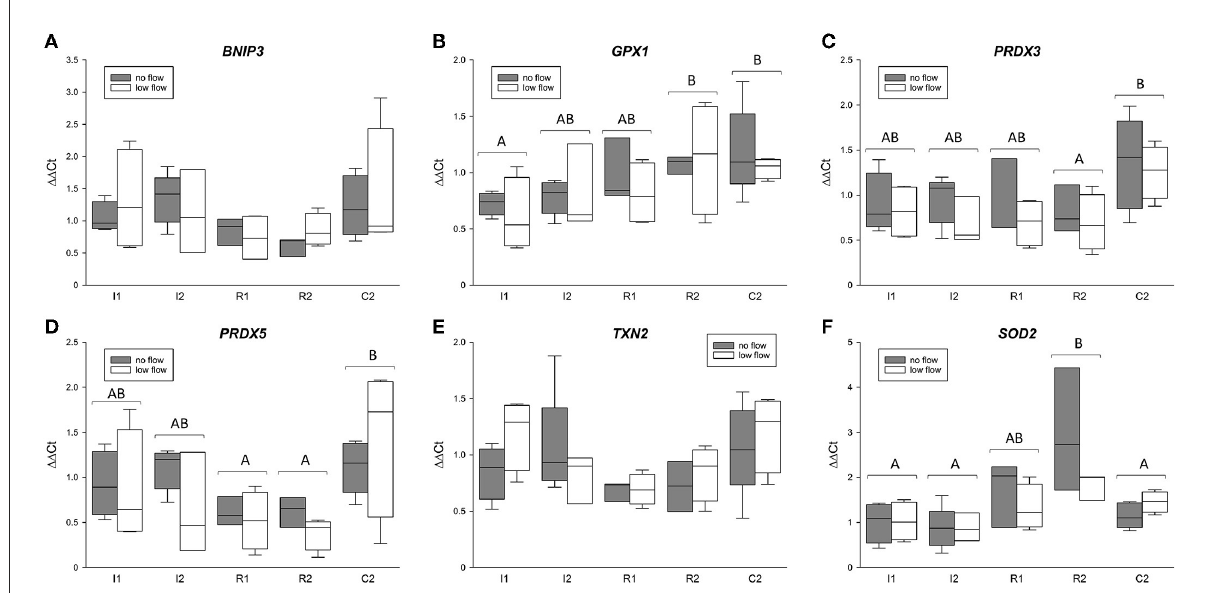
FIGURE3 mRNA expression of BNIP3 (A) , GPX1 (B) , PRDX3 (C) and 5 (D) , TXN2 (E) , and SOD2 (F) in the equine jejunum epithelium after 1 and 2h of ischemia and reperfusion, respectively. The gene expression is given relative to control tissue before the onset of ischemia, which was set to 1. Different letters indicate significant differences between the time points irrespective of the ischemia model ( p < 0.05, two-way RM ANOVA with post-hoc Holm-Sidak test). Boxes and error bars show the median, 10th, 25th, 75th, and 90th percentiles (no flow: gray; low flow: white); N = 5 (no flow) or 4 (low